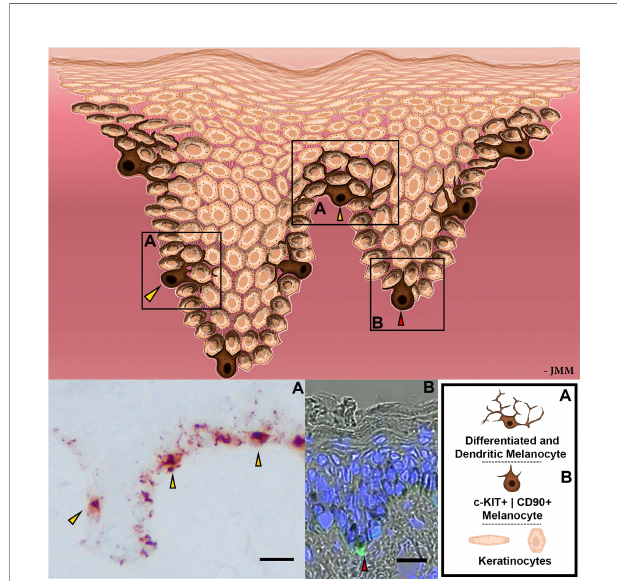
FIGURE 2 | Schematic representation of EMUs. Distinct subpopulations of melanocytes are represented by different levels of differentiation, dendricity, melanin production, and cell receptor expression. Magni fi ed images with differential melanocyte localization within the basal layer of human epidermis exhibited with gp100 (pre-melanosome antigens as detected by NKI/beteb antibody, #AB34165) immunostaining (A) or with c-KIT (in green; #orb178436) by IHC (B) . Nuclear staining is indicated by DAPI, in blue. Scale bar 20 m